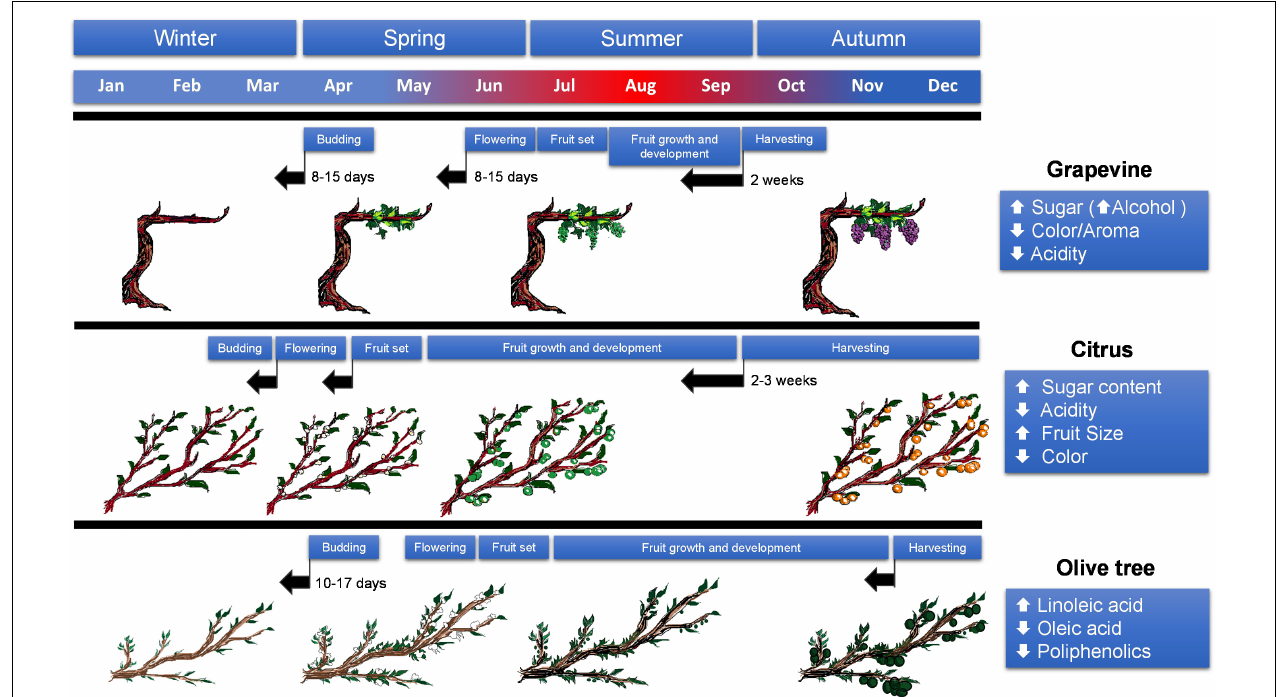
FIGURE 1 | Summary of changes in phenology and fruit quality in grapevine, citrus and olive in response to drought and high temperatures derived from climate change conditions. Black arrows indicate advances in the phenological state, blue–red coloring in the month scale indicates incidence of high (red) and low (blue)